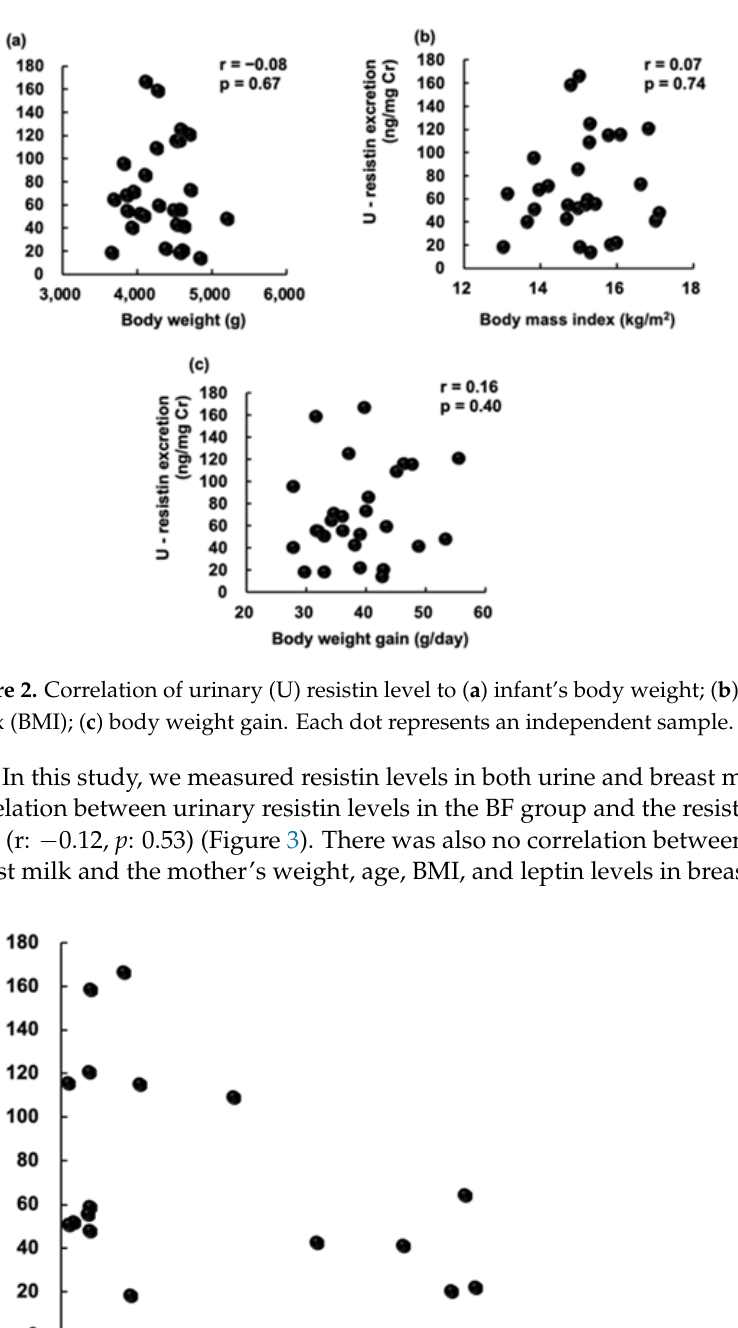
Figure 1. Urinary resistin level in breast ‐ fed group, breast milk dominant mix ‐ fed group, and for ‐ mula milk dominant mix ‐ fed group.